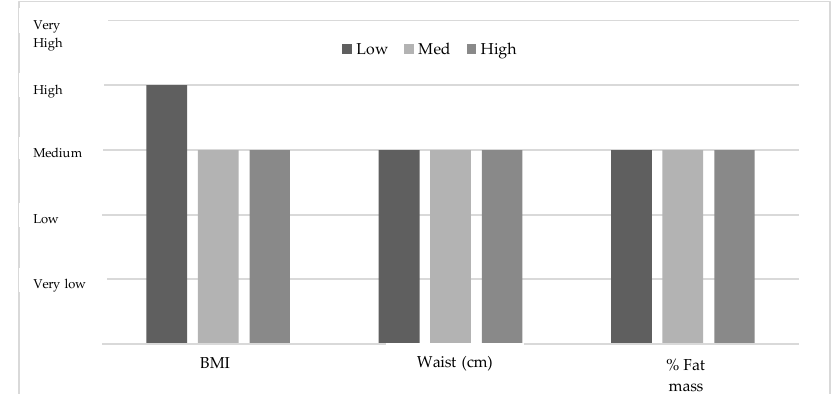
Figure 4. Mean levels of body composition variables in the boys based on the grouping by Moreno et al. (2006, 2007) [57,58].